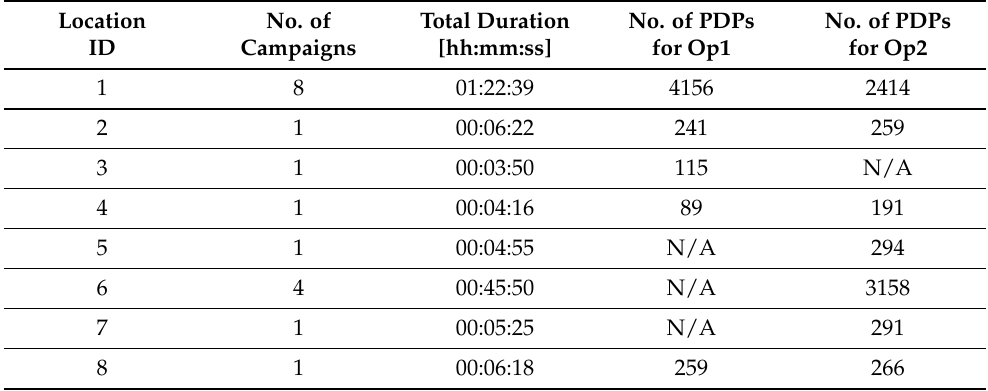
Figure 3. Measurement locations at DIET Department. Green, blue, and red lines represent walls, windows, and doors, respectively. Table 3. Summary of measurement data available at each location; an N/A label indicates that no data are available at the corresponding location due to lack of 5G coverage by the